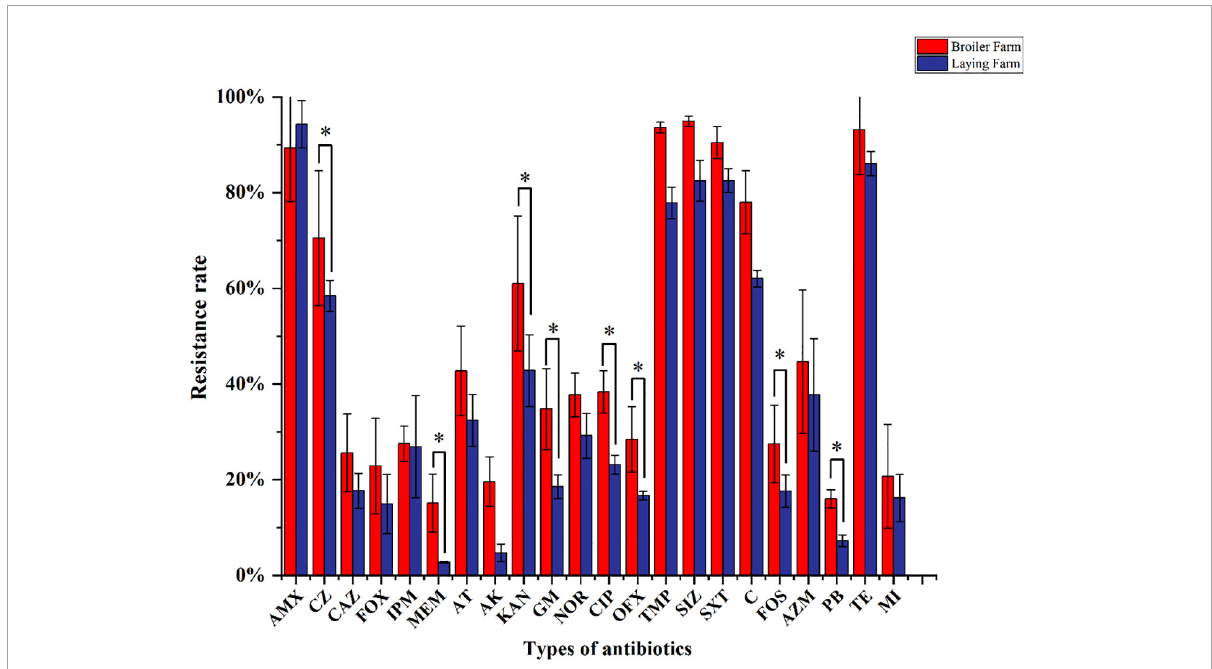
FIGURE4 Resistance rates of MDRE isolated from broilers and layers to 25 antimicrobials. AMX, Amoxicillin; CZ, Cefazolin; CAZ, Ceftazidime; FOX, Cefoxitin; IPM, Imipenem; MEM, Meropenem; AT, Aztreonam; AK, Amikacin; KAN, Kanamycin; GM, Gentamicin; CIP, Ciprofloxacin; NOR, Norfloxacin; OFX, Ofloxacin; TMP, Trimethoprim; SIZ, Sulfamethoxazole; SXT, Trimethoprim-Sulfamethoxazole; C, Chloramphenicol; FOS, Fosfomycin; AZM, Azithromycin; PB, Polymyxin B; TE, Tetracycline; MI, Minocycline.